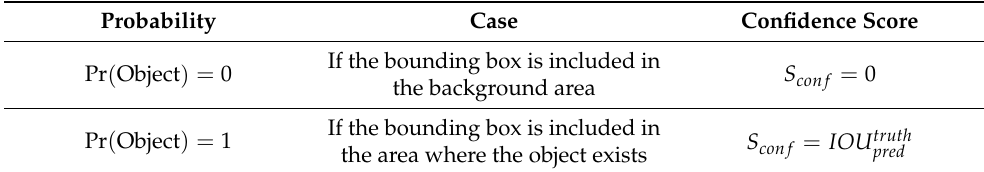
Table 1. Confidence scores according to the probability of